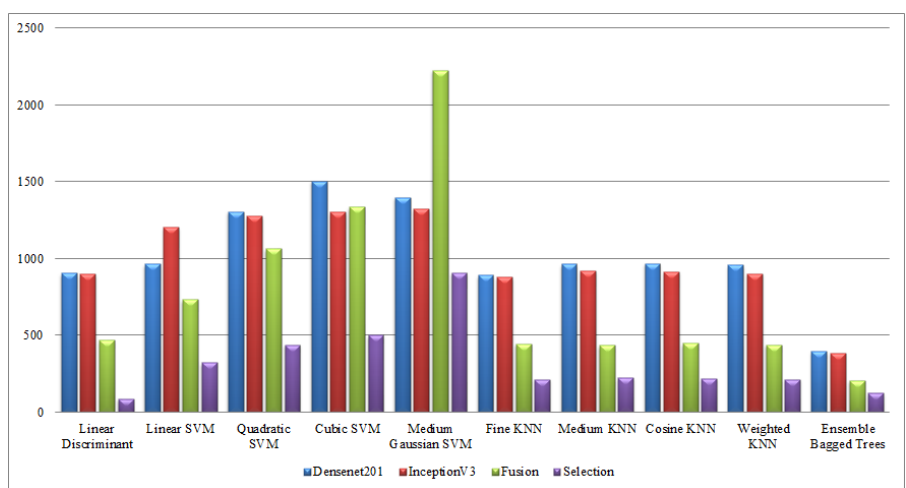
Figure 17. Computational time-based comparison of middle steps on Hollywood dataset.